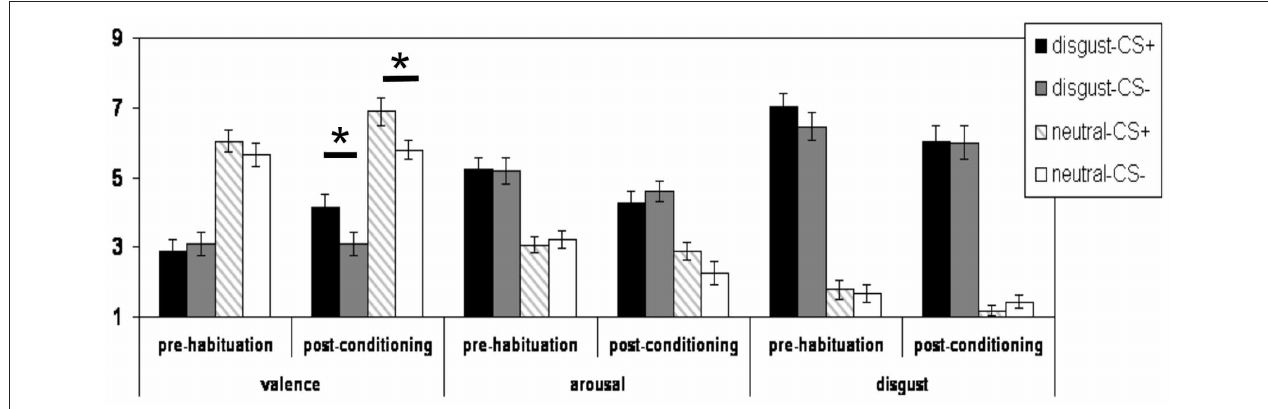
FIGURE 1 | Mean subjective valence, arousal, and disgust ratings (and standard errors of the mean) of for the CS + disg , the CS − disg , the CS + con , and the CS − con before the habituation phase and after the conditioning phase. ∗ indicates p < 0 .